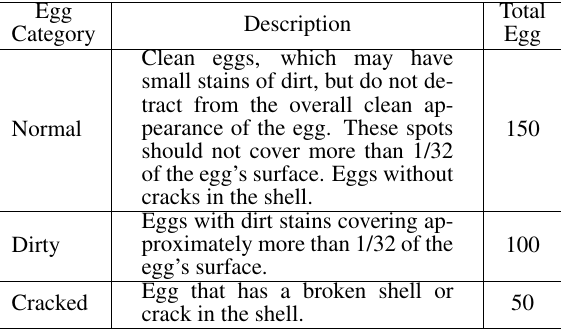
Table 2. Categories and number of collected egg samples.